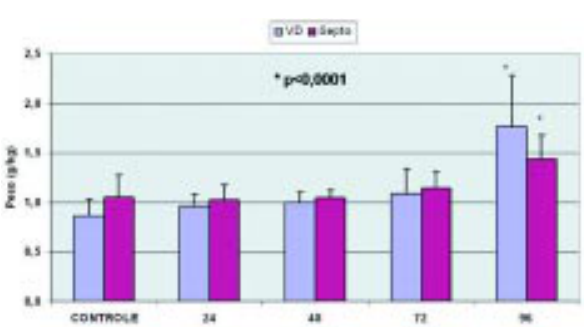
Fig. 5 - Massas do VD e do Septo (indexada para o peso corporal) avaliadas ao longo do protocolo de sobrecarga sistólica intermitente, mostrando aumento significativo de ambas as massas no grupo 96. (p<0,0001). n=7